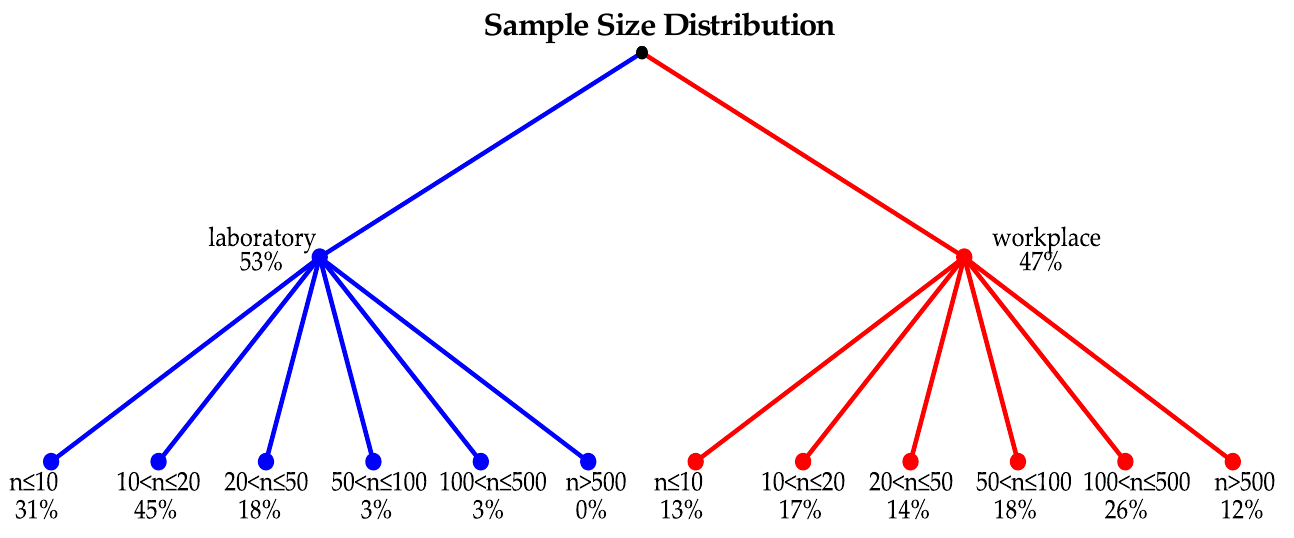
Figure 7. Sample size distribution in the laboratory setting ( on the left ) and in the workplace setting ( on the right ). The sample size was divided in six groups: n ≤ 10, 10 < n ≤ 20, 20 < n ≤ 50, 50 < n ≤ 100, 100 < n ≤ 500 and n > 500.